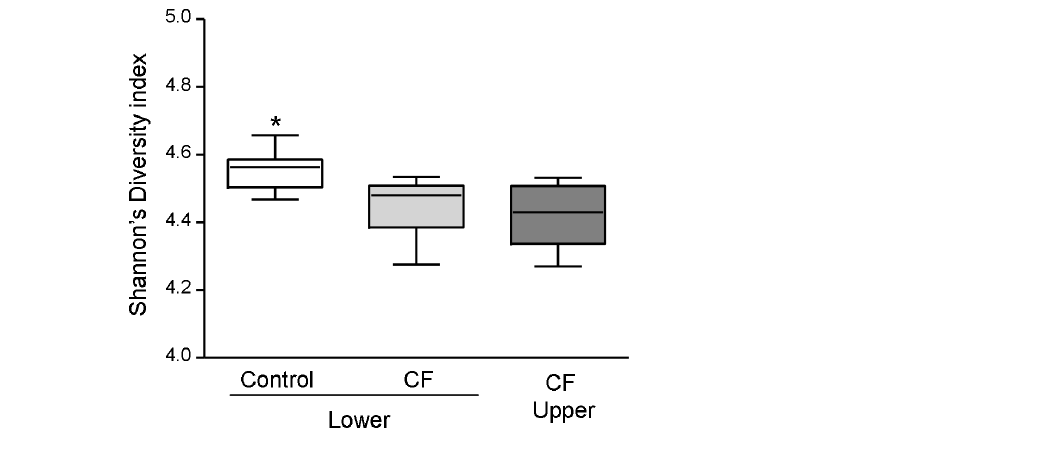
Fig. 1. Richness of the microbial communities present in the control lower airways and the CF upper and lower airways. Box and Whiskers plot of Shannon’s diversity indices for microbial communities present in the control lower airway, CF lower airway and the CF upper airway. * represents statistical significance (p 5 0.001; two-tailed t